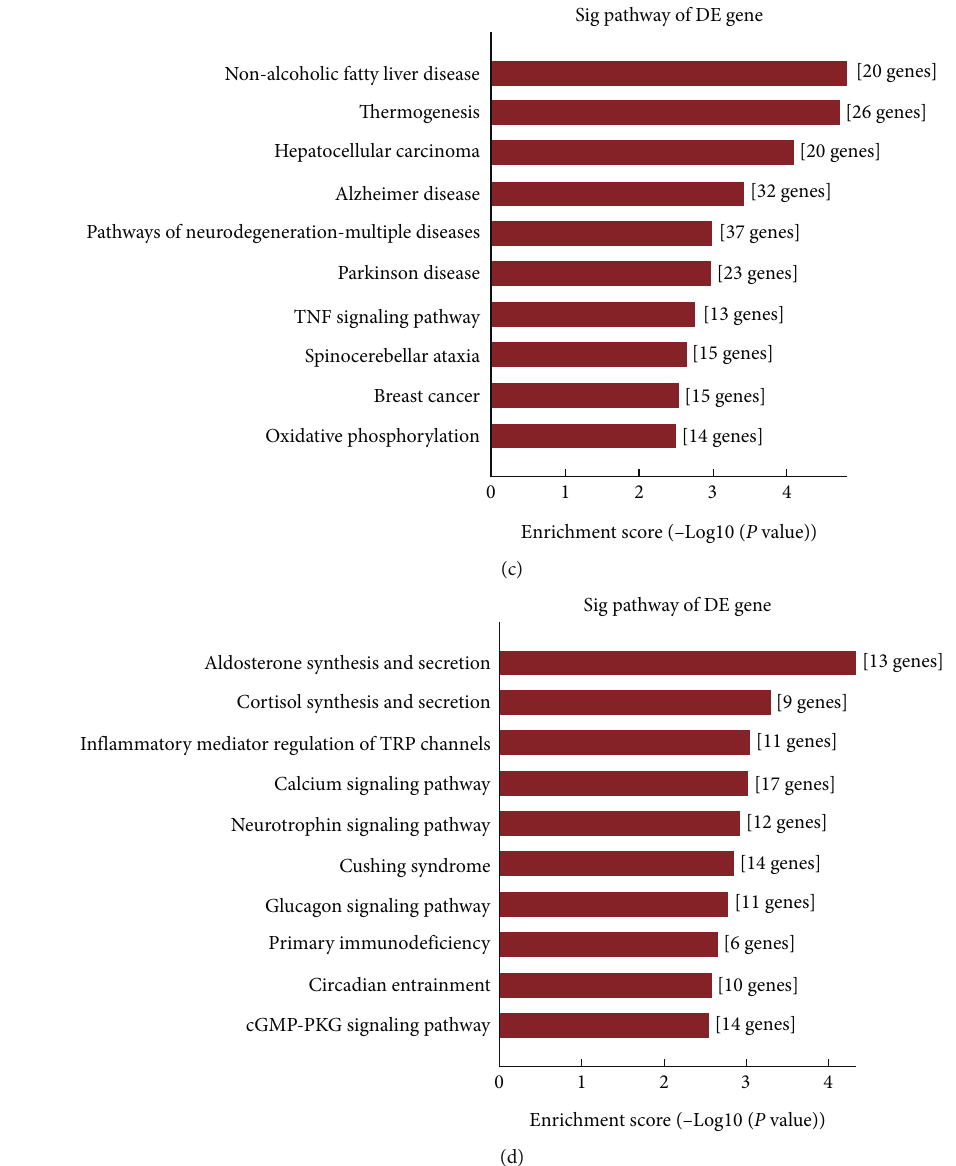
Figure 4: Functional analysis of di ff erentially methylated mRNAs. GO enrichment analysis of hypermethylated mRNAs (a) and hypomethylated mRNAs (b). Pathway analysis of hypermethylated mRNAs (c) and hypomethylated mRNAs